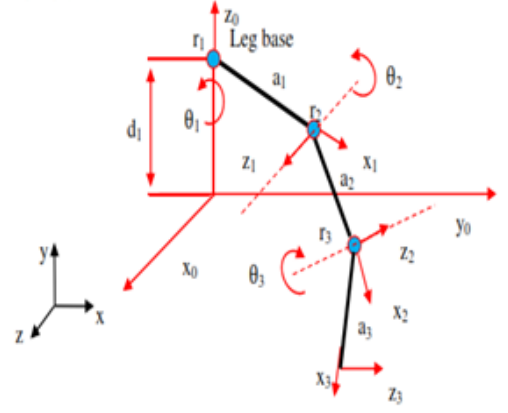
Fig. 3. Coordinate frames for one leg of a quadruped robot.